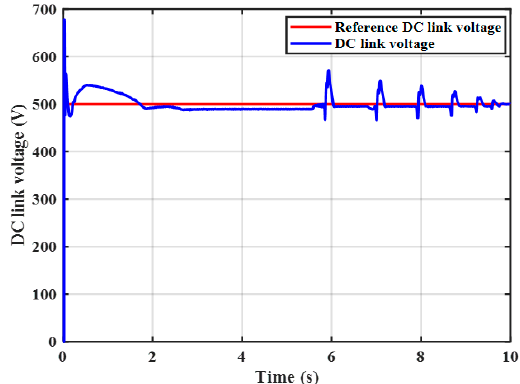
Figure 14. DC link voltage.